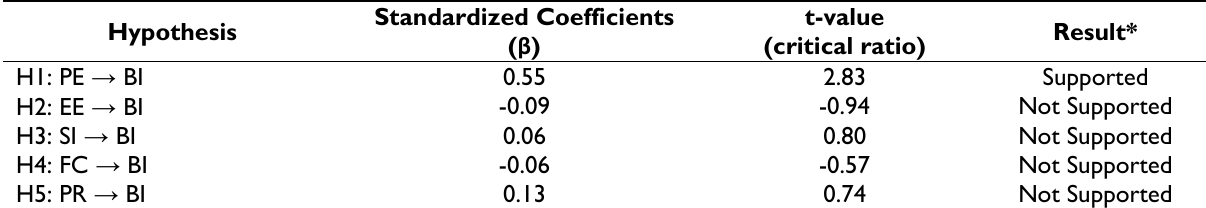
Table 6. Result of the hypothesis